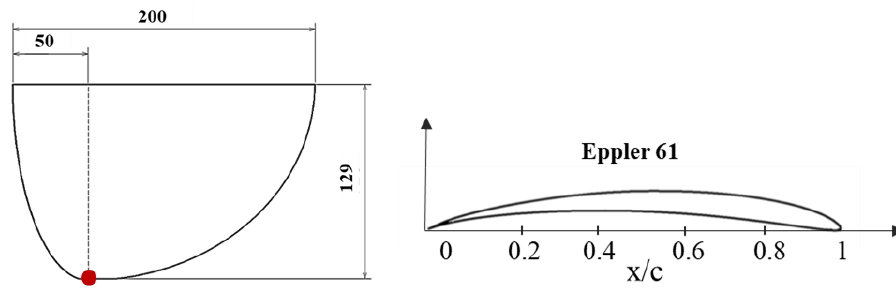
Figure 2. Zimmerman wing plantform ( left ) and Eppler 61 wing airfoil ( right ). Dimensions in mm.